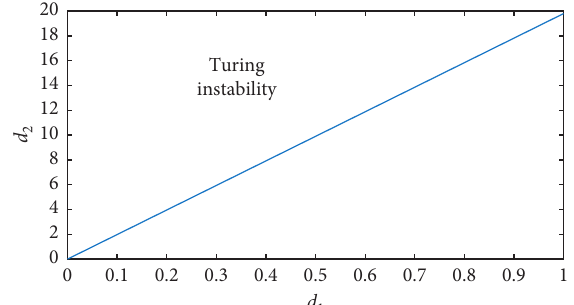
Figure 3: A region diagram of the occurrence of Turing instability for diffusion